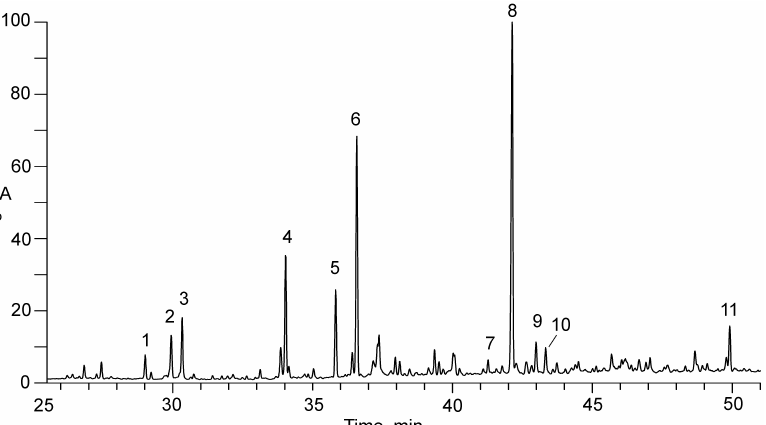
Fig. 1. GC/MS total ion chromatogram (TIC) obtained for a fine daytime HVDS filter sample collected during the transition period (26– 27 October). (1) cis- 2-methyl-1,3,4-trihydroxy-1-butene; (2) 3-methyl-2,3,4-trihydroxy-1-butene; (3) trans -2-methyl-1,3,4-trihydroxy-1- butene; (4) malic acid; (5) 2-methylerythritol; (6) 2-methylthreitol; (7) mannosan; (8) levoglucosan; (9) 1,6-anhydro- β -D-glucofuranose; (10) arabitol; and (11)